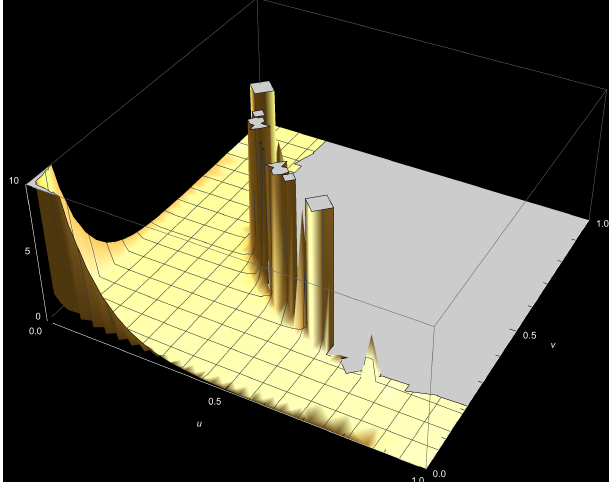
Figure A9. The bivariate Kumaraswamy density (Equation (1)) plot, where α = 0.8, β = 0.8, θ = 4.5 and δ =